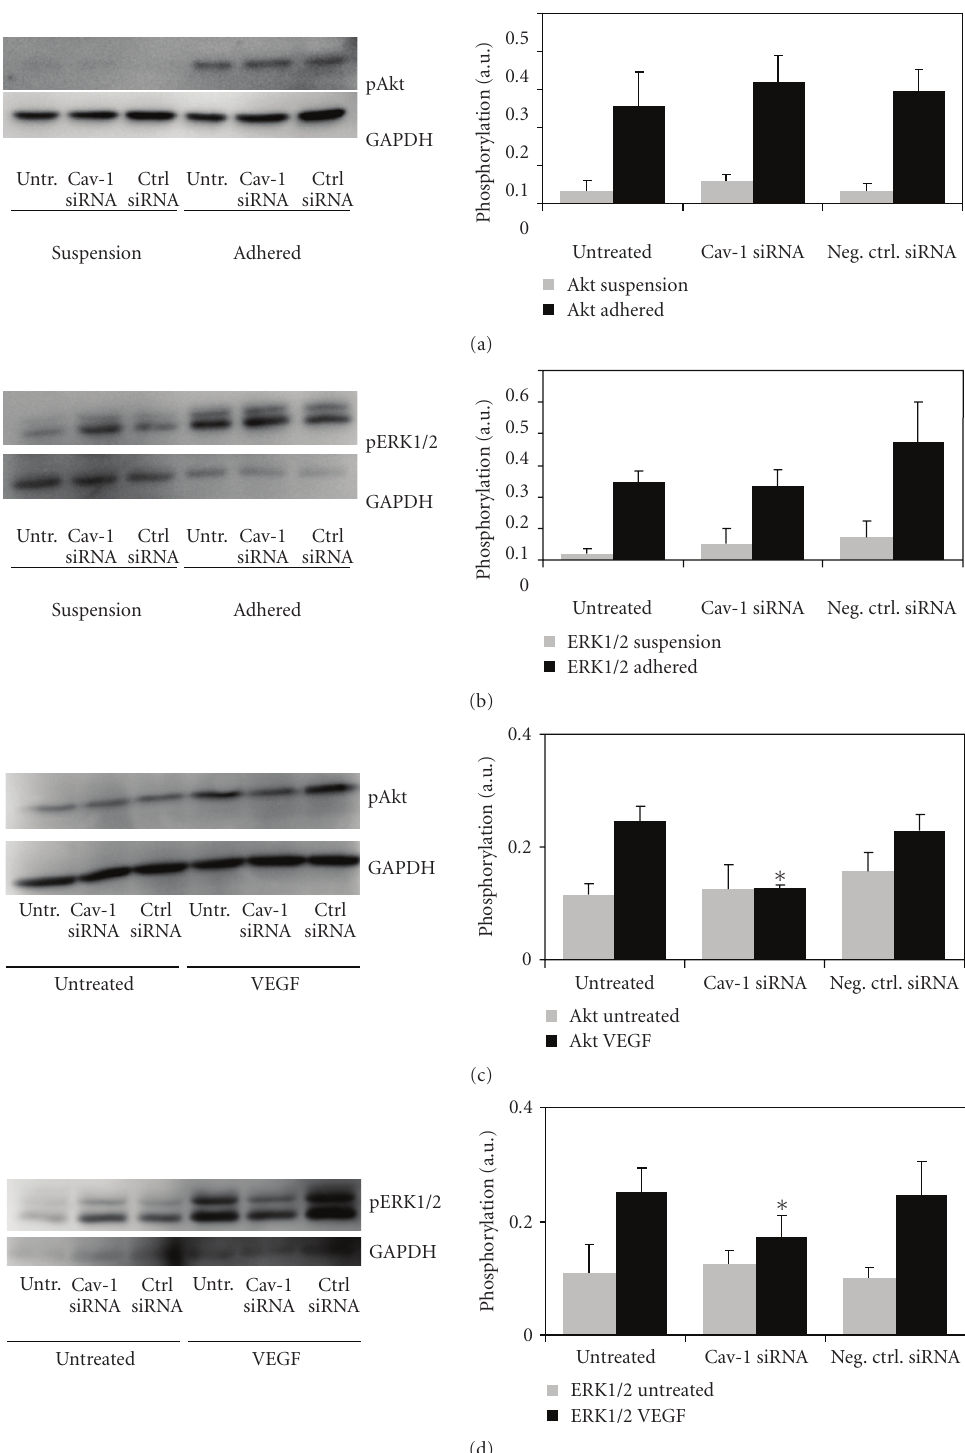
Figure 4: Activation of Akt and ERK1/2 in response to external stimuli. HUVECs were transfected with either caveolin-1 siRNA, negative control siRNA, or left untreated. 48 hours after transfection, cells were subjected to the following stimuli. (a), (b) Cells were kept in suspension for 30 minutes and then plated on fibronectin-coated culture plates to activate integrin-mediated signaling. Phosphorylation of both (a) Akt and (b) ERK1/2 increased significantly when compared to cells in suspension. No significant di ff erences in activation levels were detected between HUVECs with high or low caveolin-1 levels. (c), (d) Cells were starved in basal medium and then treated with 200ng/mL VEGF for 10 minutes. Phosphorylation of both (c) Akt and (d) ERK1/2 in response to this stimulus was significantly lower in cells with low levels of caveolin-1 than in cells that were treated with negative control siRNA ( ∗ P < . 01). All bars are averages of three separate